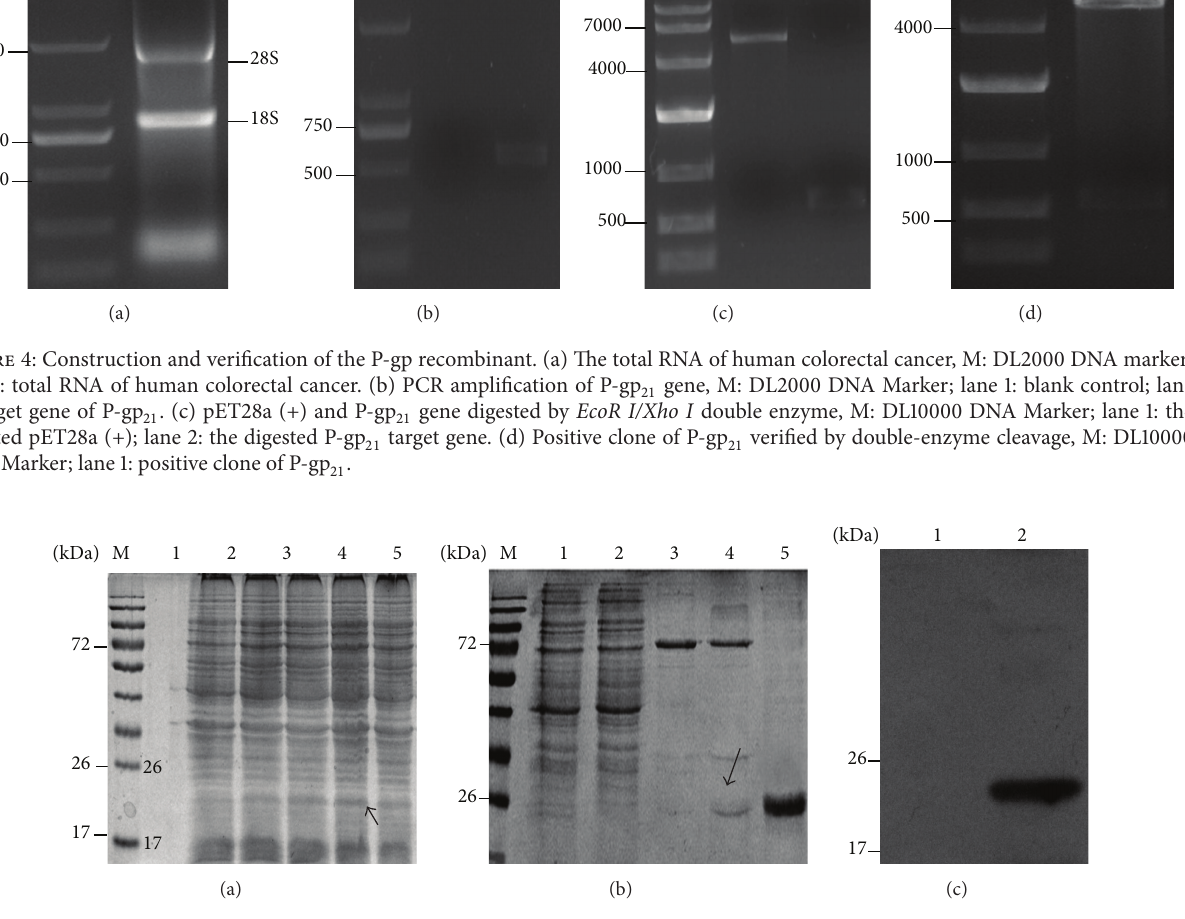
Figure 5: Expression, purification, and verification of the P-gp 21 . (a) SDS-PAGE image of the P-gp 21 expression induced by IPTG: before induction (lane 1), induced for 1 hour (lane 2), induced for 2 hours (lane 3), induced for 3 hour (lane 4), and induced for 4 hours (lane 5); (b) purification of the P-gp 21 protein by HiTrap HP, before passing Ni affinity column (lane 1), sample after passing Ni affinity column (lane 2), the washout of the Ni affinity column with 50mM imidazole (lane 3), the washout of the Ni affinity column with 150mM imidazole (lane 4), and the washout of the Ni affinity column with 300mM imidazole (lane 5); (c) P-gp 21 protein verified by Western blot: the recombinant with P-gp 21 before induction (lane 1), purified P-gp 21 protein (lane 2), antigen (P-gp 21 protein), primary antibody (mouse anti-His antibody), and secondary antibody (HRP-labeled goat anti-mouse IgG